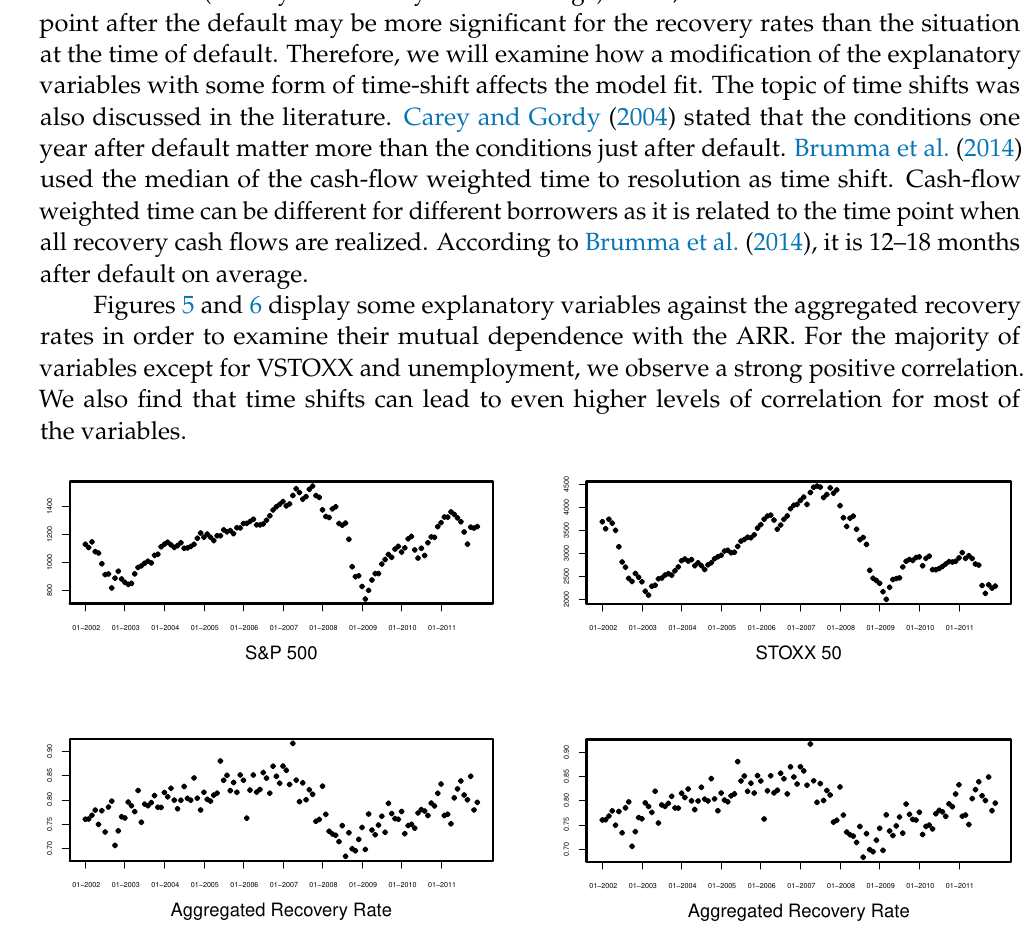
Figure 5. S&P500 ( top left ) and STOXX 50 ( top right ) vs. aggregated recovery rates ( bottom